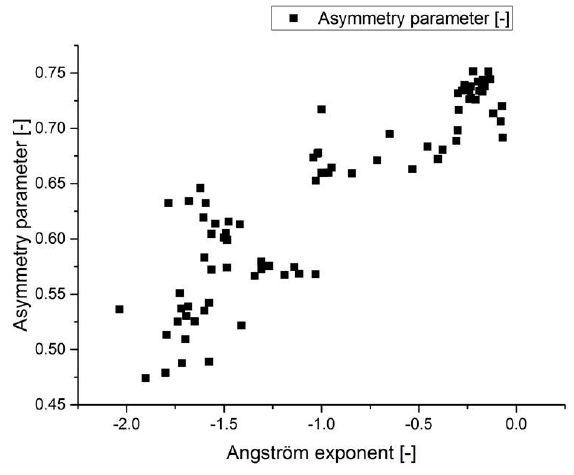
Figure 8. Relationship between the measured Angström exponent and the asymmetry parameter using the measured phase function.